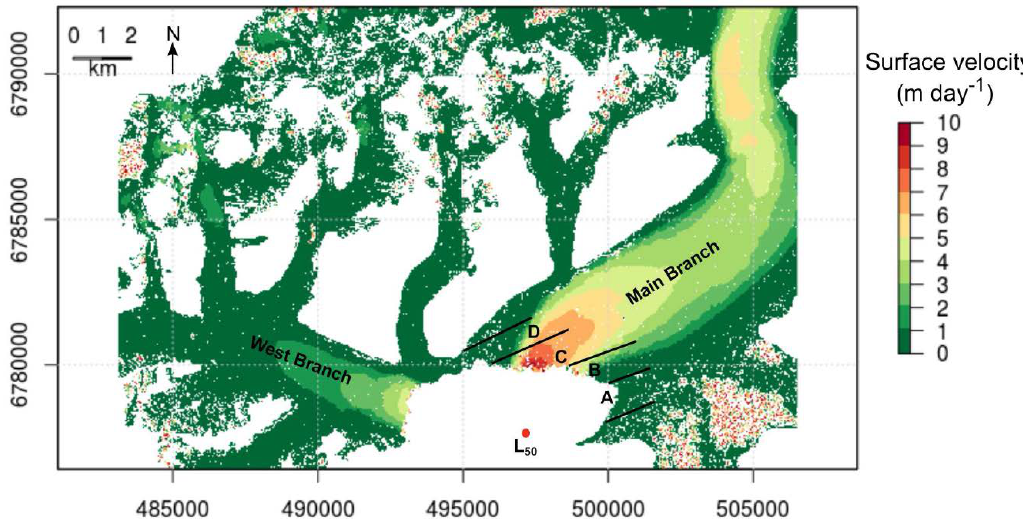
The surface velocity of Columbia Glacier in the lower catchment area during 09/30/2011–10/11/2011. The branches are indicated by their names “Main Branch” and “West Branch”. A, B, C and D depict the imaginary zones of the main branch based on different surface velocities and frontal retreat. Red circle (L 50 ) indicates the measurement point in